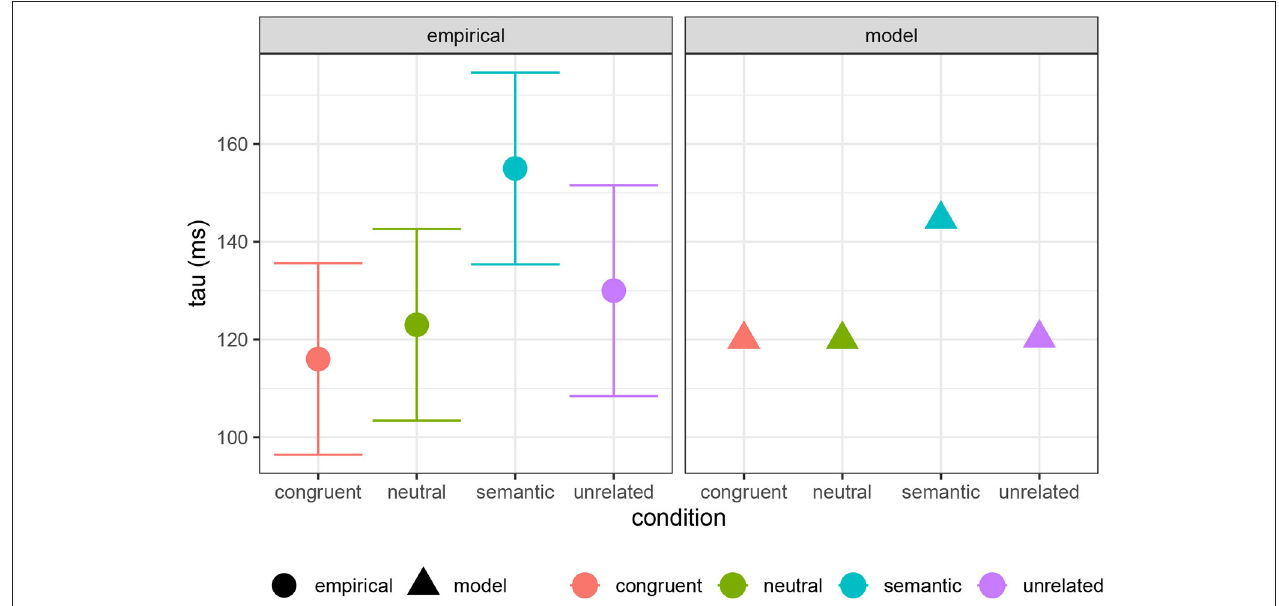
FIGURE 11 | Empirically estimated τ parameter of Ex-Gaussian RT distribution for PWI conditions from Roelofs and Piai (2017), compared with model predictions ( τ = 120 + 85 × Decision cost).